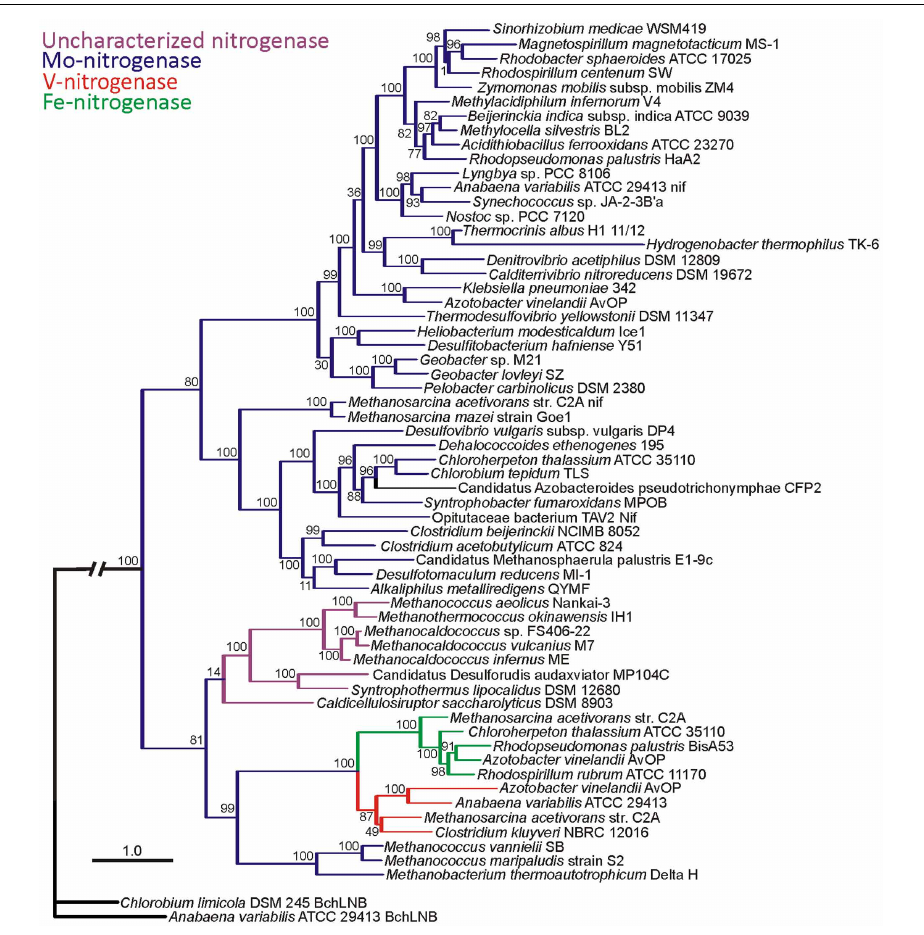
FIGURE 2 | Maximum-likelihoodphylogenetic reconstruction of a concatenation of Nif/Anf/Vnf and uncharacterized HDK protein sequences. Individual protein sequences were aligned, concatenated, and subjected to evolutionary reconstruction as described previously (Boyd et al., 2011b). The metal composition of the nitrogenase active site clusters are overlaid in blue (Nif), purple (“uncharacterized nitrogenase”), red (Vnf), and green (Anf). Bootstrap values are indicated at the nodes. Concatenations of paralogous proteins involved in the synthesis of chlorophyll/bacteriochlorophyll(Bch/ChlLNB) were used to root the phylogeny. The hash at the root was introduced to conserve